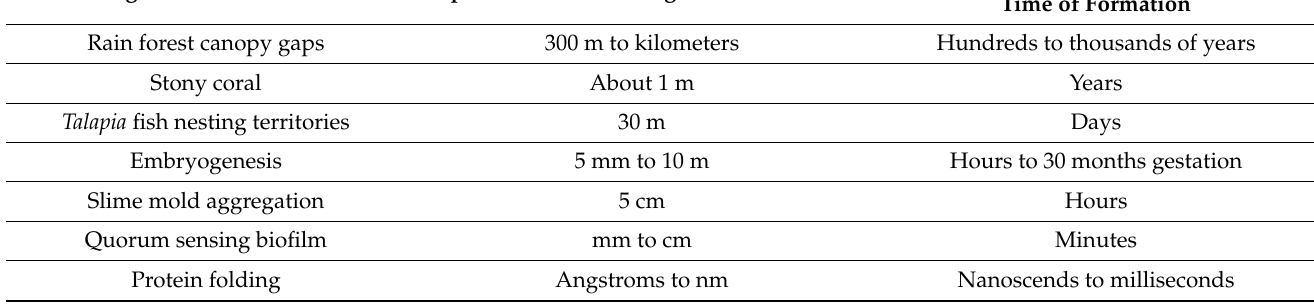
Table 2. Spatio-temporal variation in Voronoi tessellation patterns produced by different mechanisms in phylogenetically diverse contexts. Biological Voronoi Pattern Spatial Variation: Rough Potential Scale